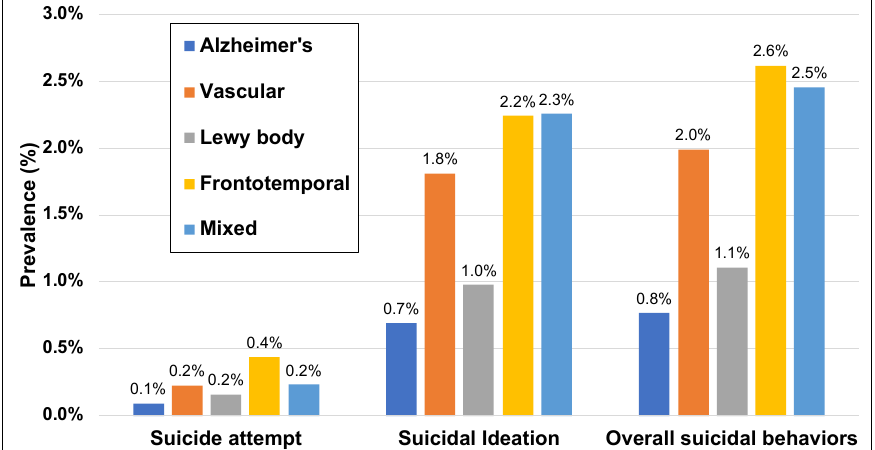
Figure 1. Prevalence of suicidal behaviors, including suicidal ideation and suicide attempt, in hospitalizations in people with Alzheimer’s disease (AD) and AD-related dementias. Data from the Nationwide Readmissions Database, 2016–2018, in the United States.